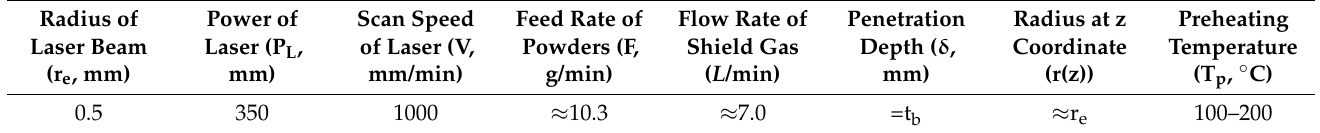
Table 2. Conditions for deposition experiments and